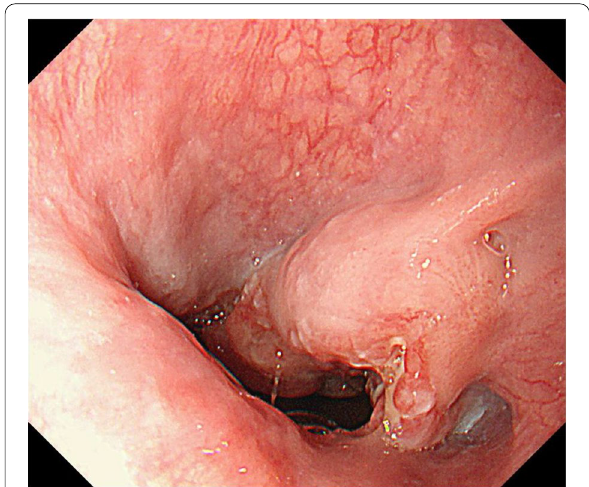
Fig. 1 Preoperative upper gastrointestinal endoscopy. Endoscopy revealed a type 2 tumor spanning the endothelial cell junction to the abdominal